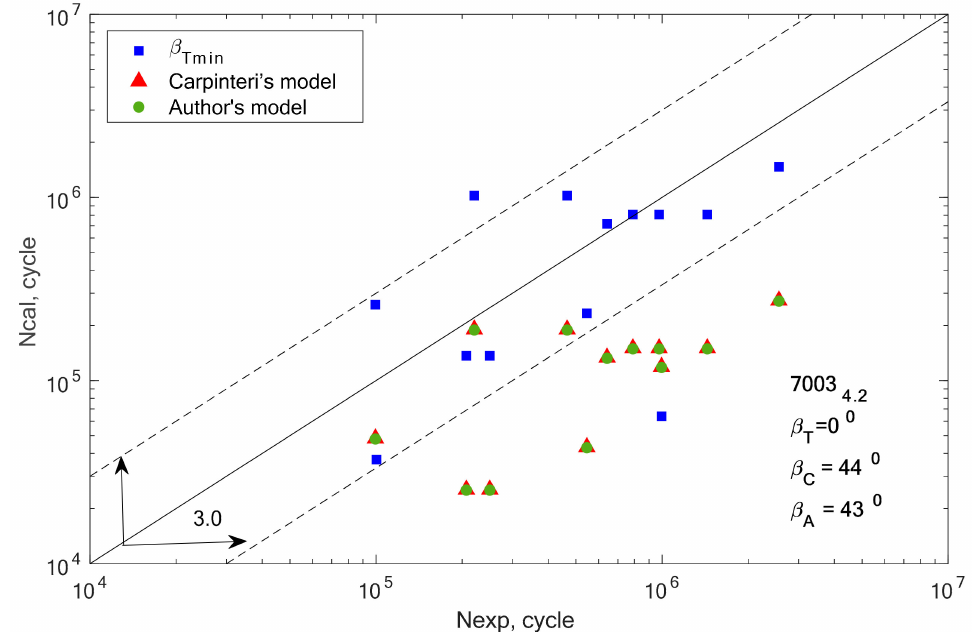
Figure 12. Comparison of the obtained design and experimental life for aluminium alloy 7003-4.2 for the cyclic bending–torsion combination.